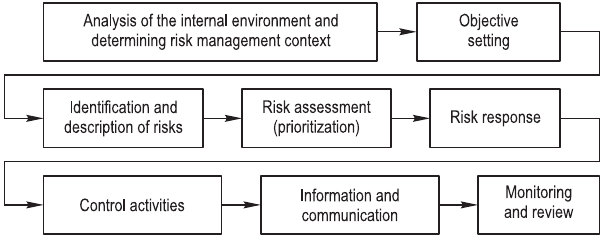
Fig. 6 . Joint risk management framework